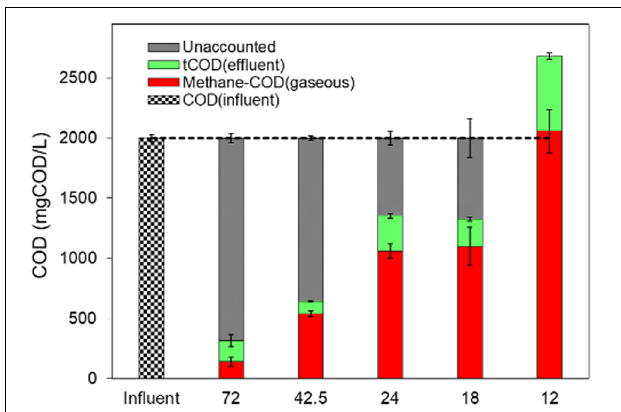
FIGURE 3 | COD balance for the DSC-FF reactor at the different HRTs of 72, 42.5, 24, 18, and 12 h along with the influent COD (equivalent to 2 gCOD/L) shown as reference.